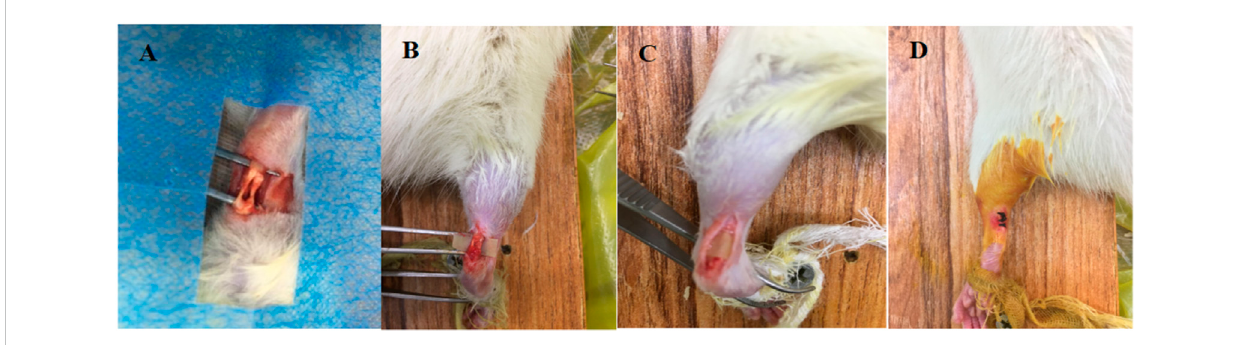
FIGURE 1 (A) Creation of Achilles tendon defect; (B) Transfer of PTMC/DH carrier fi lm to Achilles tendon defect; (C) Complete encapsulation of Achilles tendon defect with PTMC/DH fi lm; (D) Wound